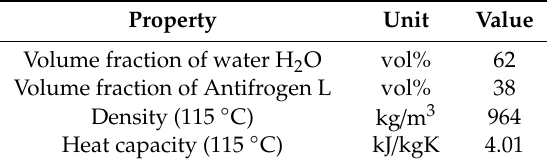
Table 3. Properties of the cooling